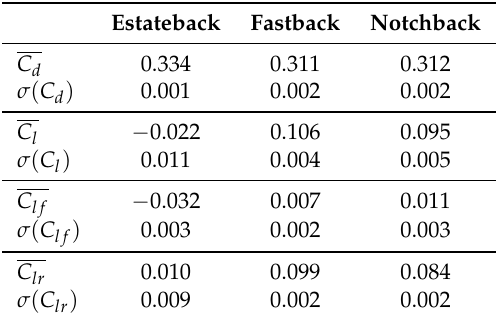
Table 3. Average force coefficients from all tests and the standard deviation of the averages from each